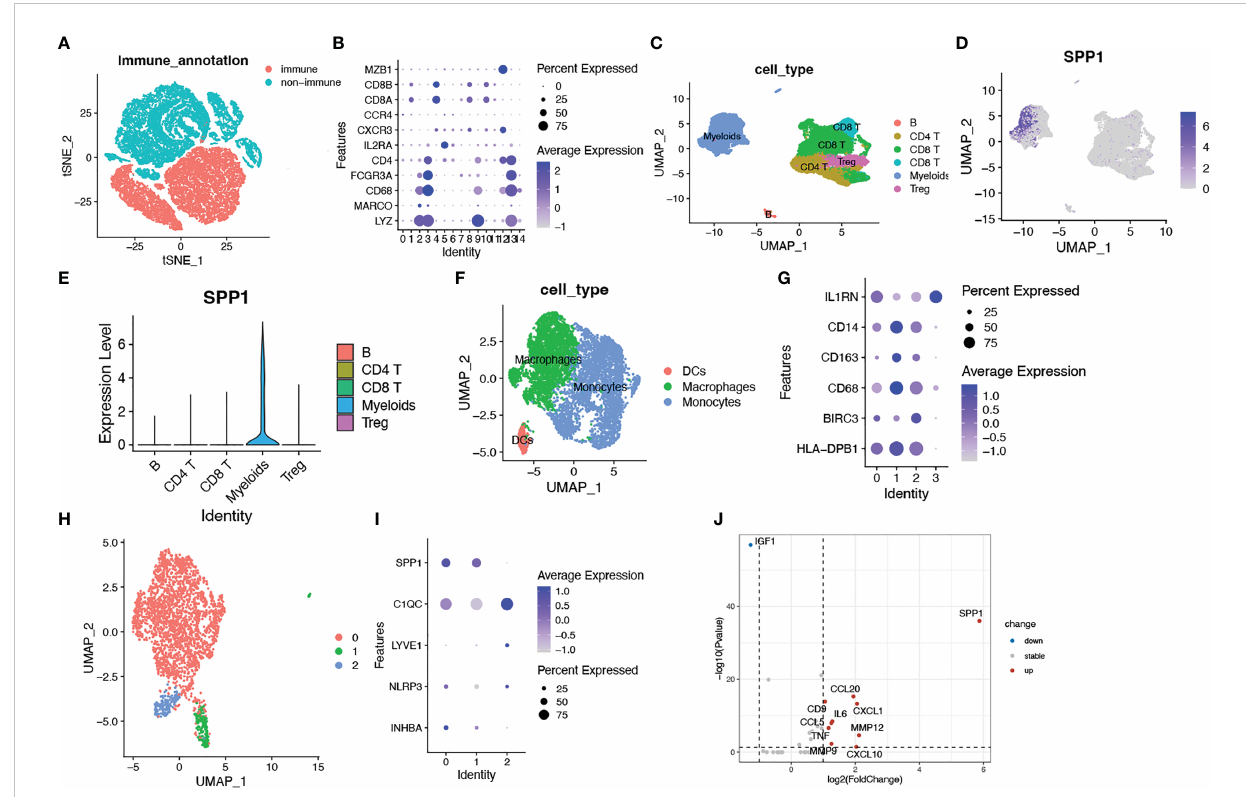
FIGURE 6 Identi fi cation of SPP1 + macrophages as a key imponent in cell senescence of colorectal cancer based on scRNA transcriptomic analysis. (A) tSNE plots showing immune cell and non-subsets identi fi ed by the CD45 marker; (B) Bubble plots showing the expression of marker genes in all immune cell clusters. Dot size indicates the percent expressed genes and color indicates the expression strength levels; (C) UMAP plot showing immune cell clusters de fi ned according to the marker genes; (D) The expression of SPP1 on all immune cells; (E) Violin plot showing SPP1 expression on various types of immune cells; (F) UMAP plot showing myeloid cell clusters de fi ned according to the marker genes; (G) Bubble plots showing the expression of marker genes in myeloid cell clusters; (H) UMAP plot showing three subsets of macrophages; (I) Bubble plots showing macrophage related genes; (J) Volcano plots showing differentially expressed SenMayo genes between SPP1 + and SPP1-